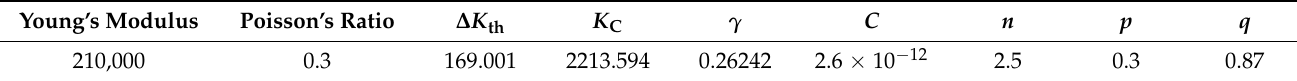
Table 1. Material parameters and fracture mechanical material parameters.